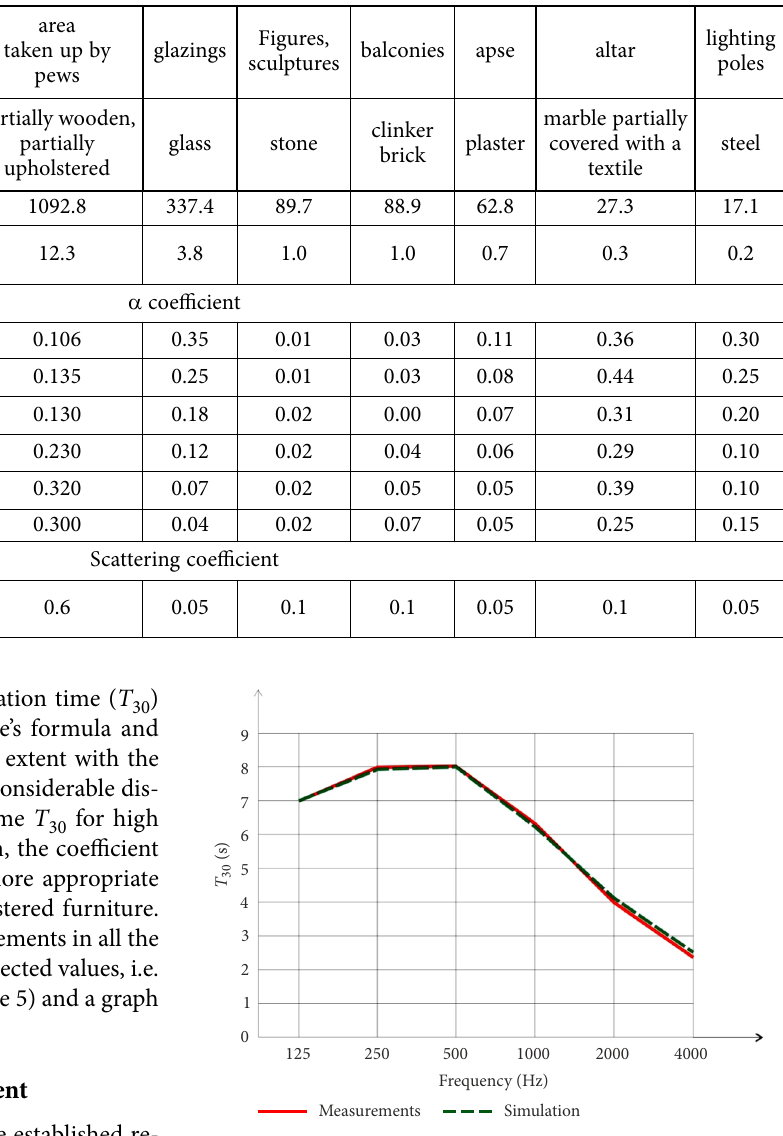
Table 4. Material properties selected for the simulation